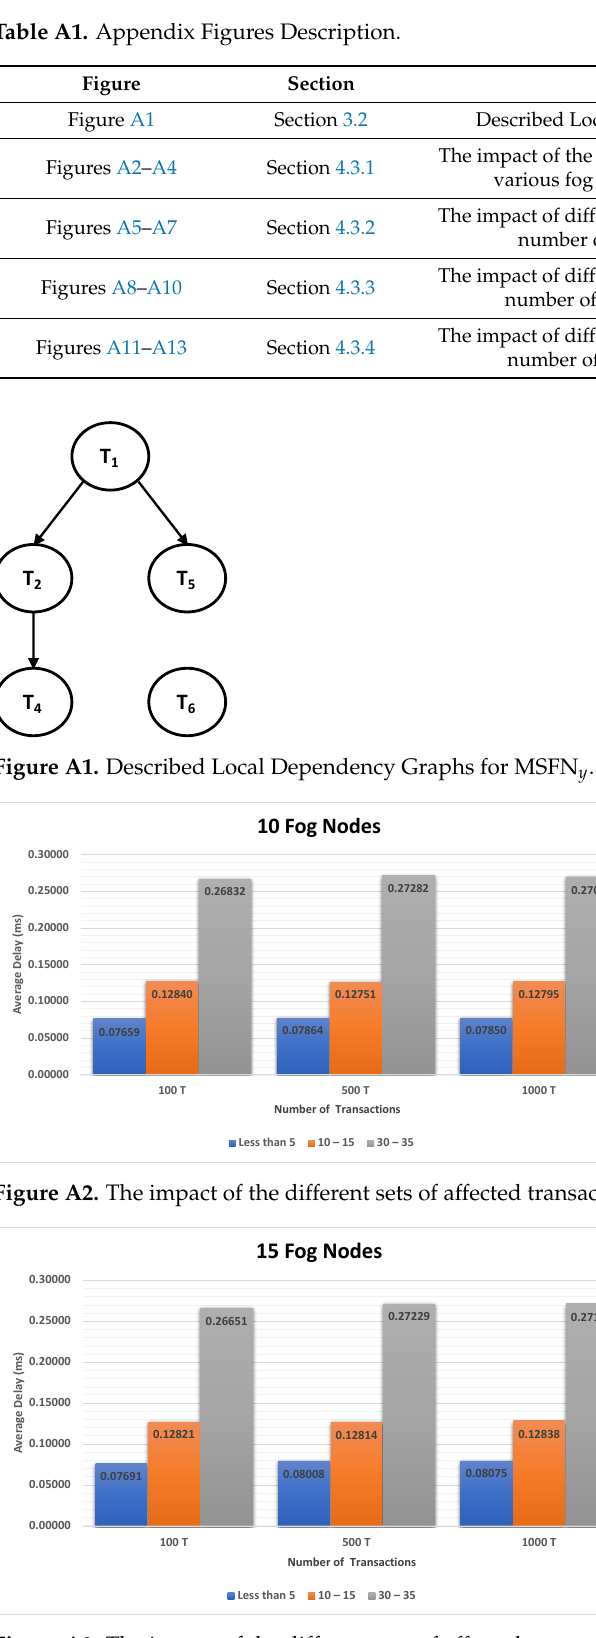
Figure A3. The impact of the different sets of affected transactions on 15 fog